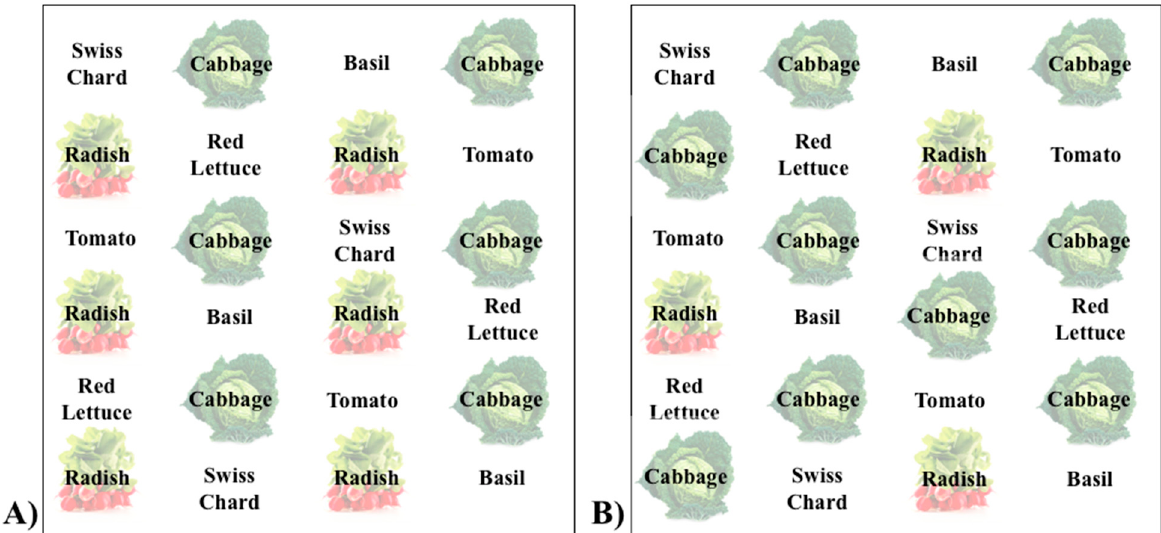
Figure 1. Arrangement of host plants (cabbage and radish) and non-host plants (red lettuce, Swiss chard, tomato, basil) in experimental arrays. ( A ) This arrangement was used for the Day 2 test array and for the Day 1 treatment array where cabbage and radish were equally abundant. ( B ) This arrangement was used for the Day 1 treatment arrays when a host was rare, in this case with radish as the rare host.